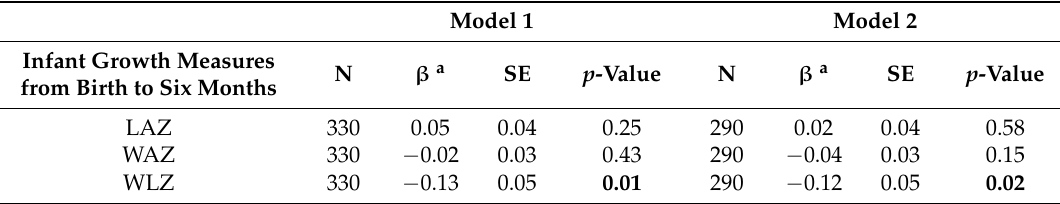
Table 3. Associations of HEI–2015 total scores from the third trimester of pregnancy through three months postpartum with infant growth measures from birth to six